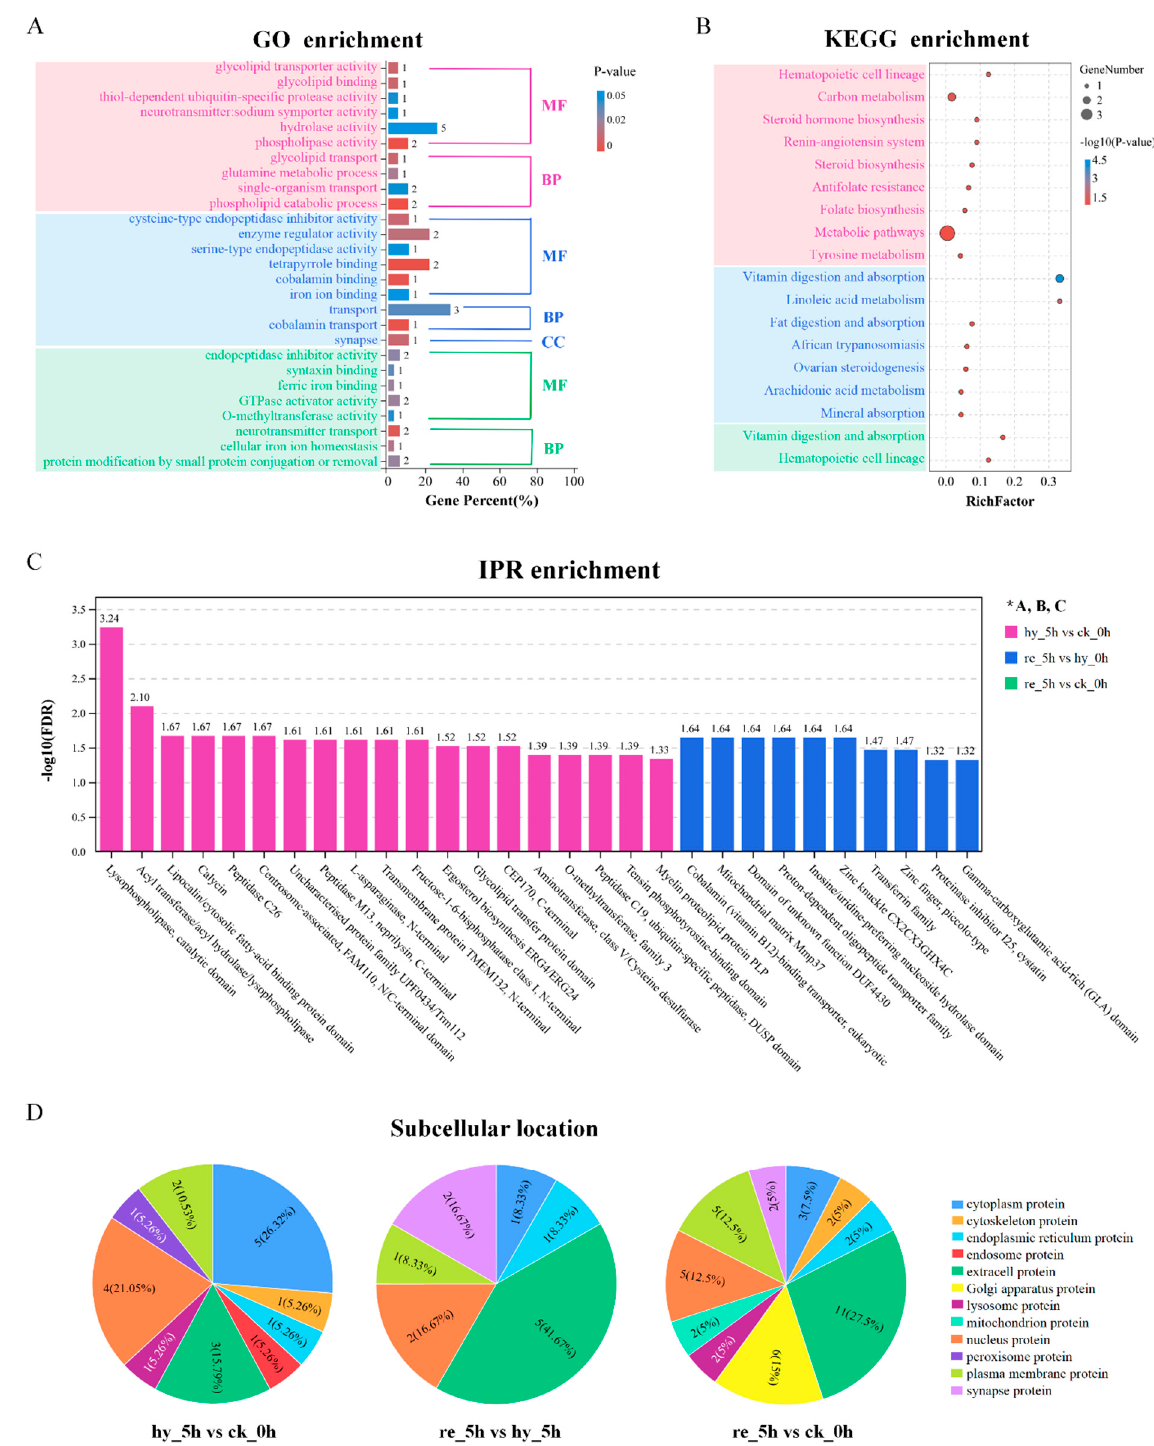
Figure 5. Bioinformatic analyses of DAPs in the brain: ( A – C ) GO, KEGG pathway, and IPR enrichment analyses of DAPs obtained by pairwise comparisons in the brain; ( D ) subcellular location analysis of DAPs obtained by pairwise comparisons in the brain. DAP, differentially abundant protein; GO, Gene Ontology; KEGG, Kyoto Encyclopedia of Genes and Genomes; IPR, InterPro. The brain-derived DAPs were subjected to KEGG enrichment analysis, and nine, seven, and two pathways were significantly enriched in the three comparisons, respec- tively (Figure 5B). Among them, hematopoietic cell lineage, renin–angiotensin system,